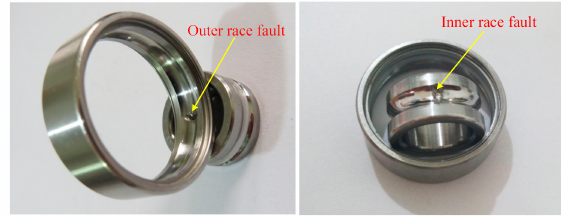
Figure 5. Fault bearings used in the